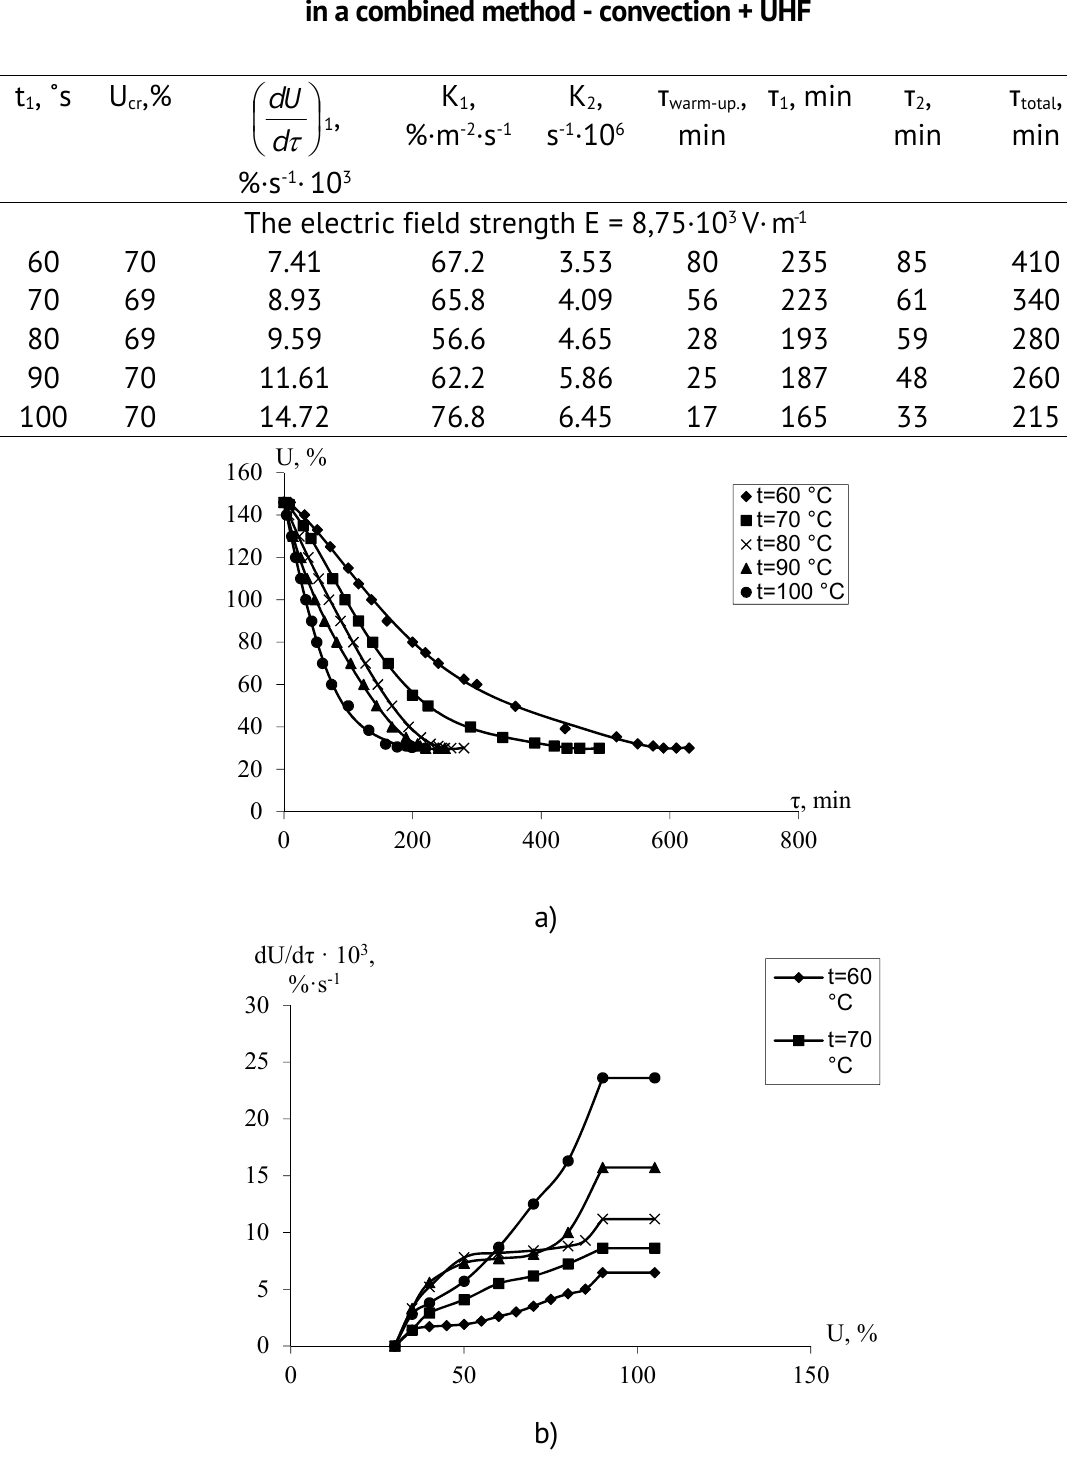
Figure 1. The drying curve (a) and drying rate (b) of kernels of apricot stone by convective energy